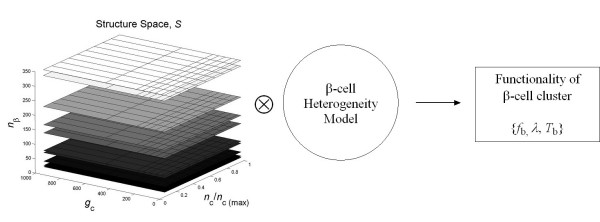
Simulation schema.